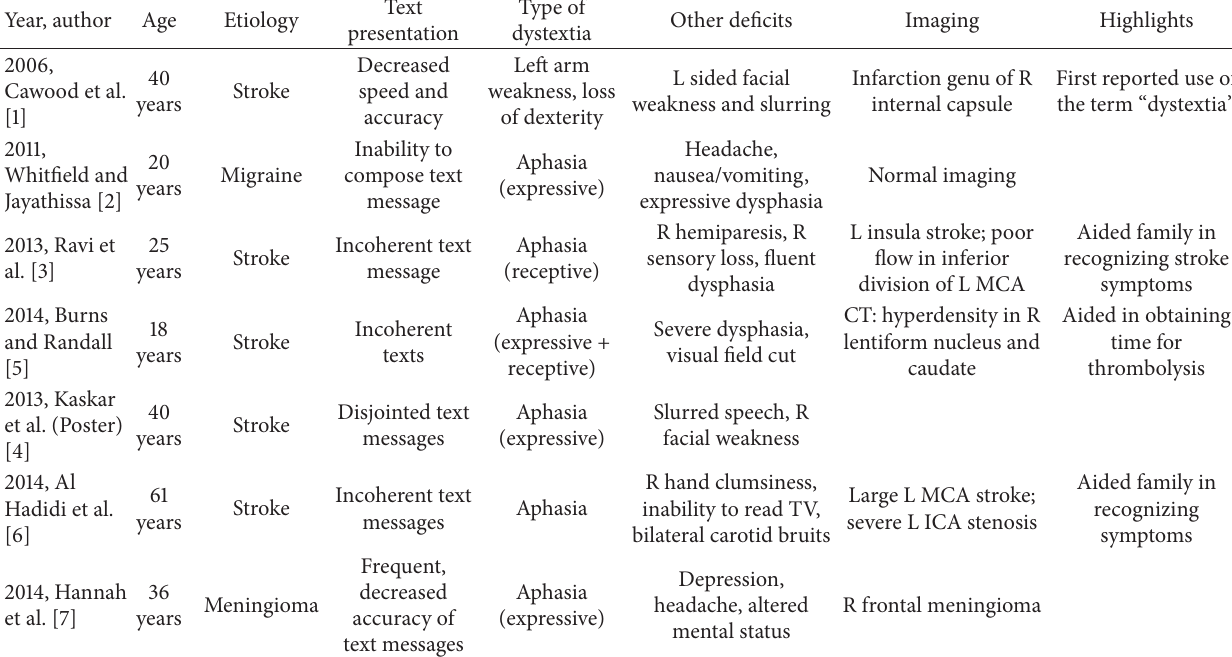
Table 1: Literature review of cases with